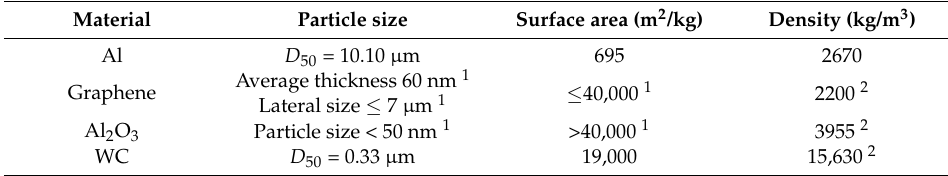
Figure 1. Scanning electron microscopy, secendary electrons mode (SEM/SE) images from ( a ) the Al powder and ( b ) from the pristine multi-walled carbon nanotubes (MWCNT); Transmission electron microscopy (TEM) images from the ( c ) pristine Graphene and ( d ) tungsten carbide (WC). Table 1. Particle characteristics of some